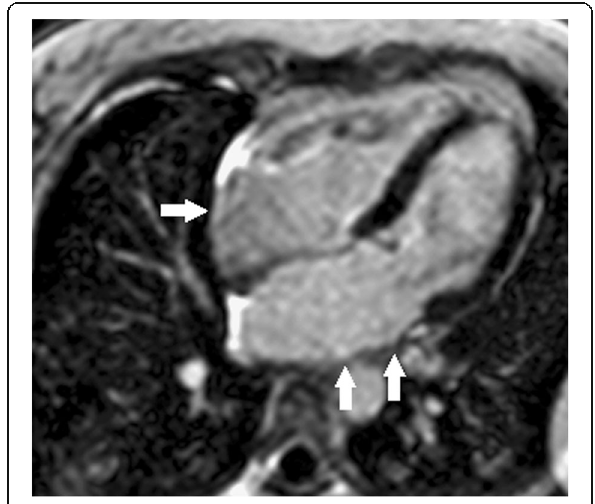
Fig. 3 DE-MRI showing mild atrial fibrosis (involves a part of the posterior wall of the left atrium and a part of the right atrium, arrows)